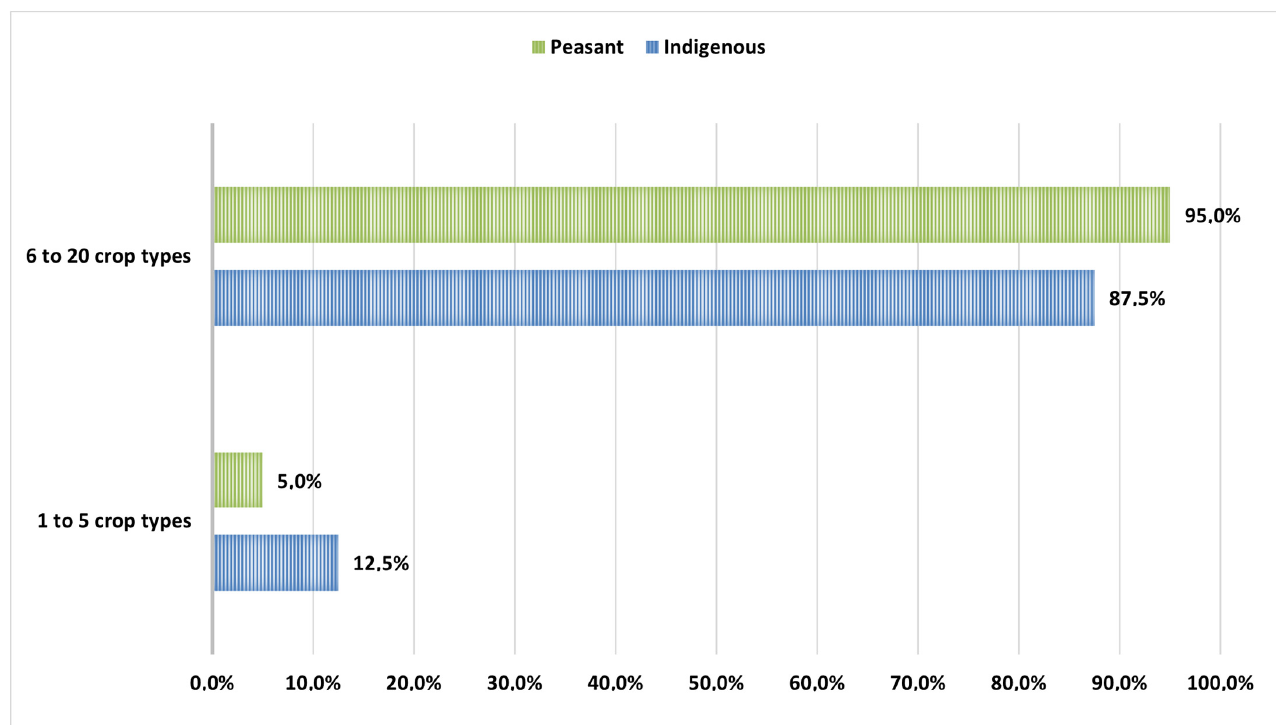
Figure 5. Product diversification in peasant and indigenous farms. Source: generated by the authors.